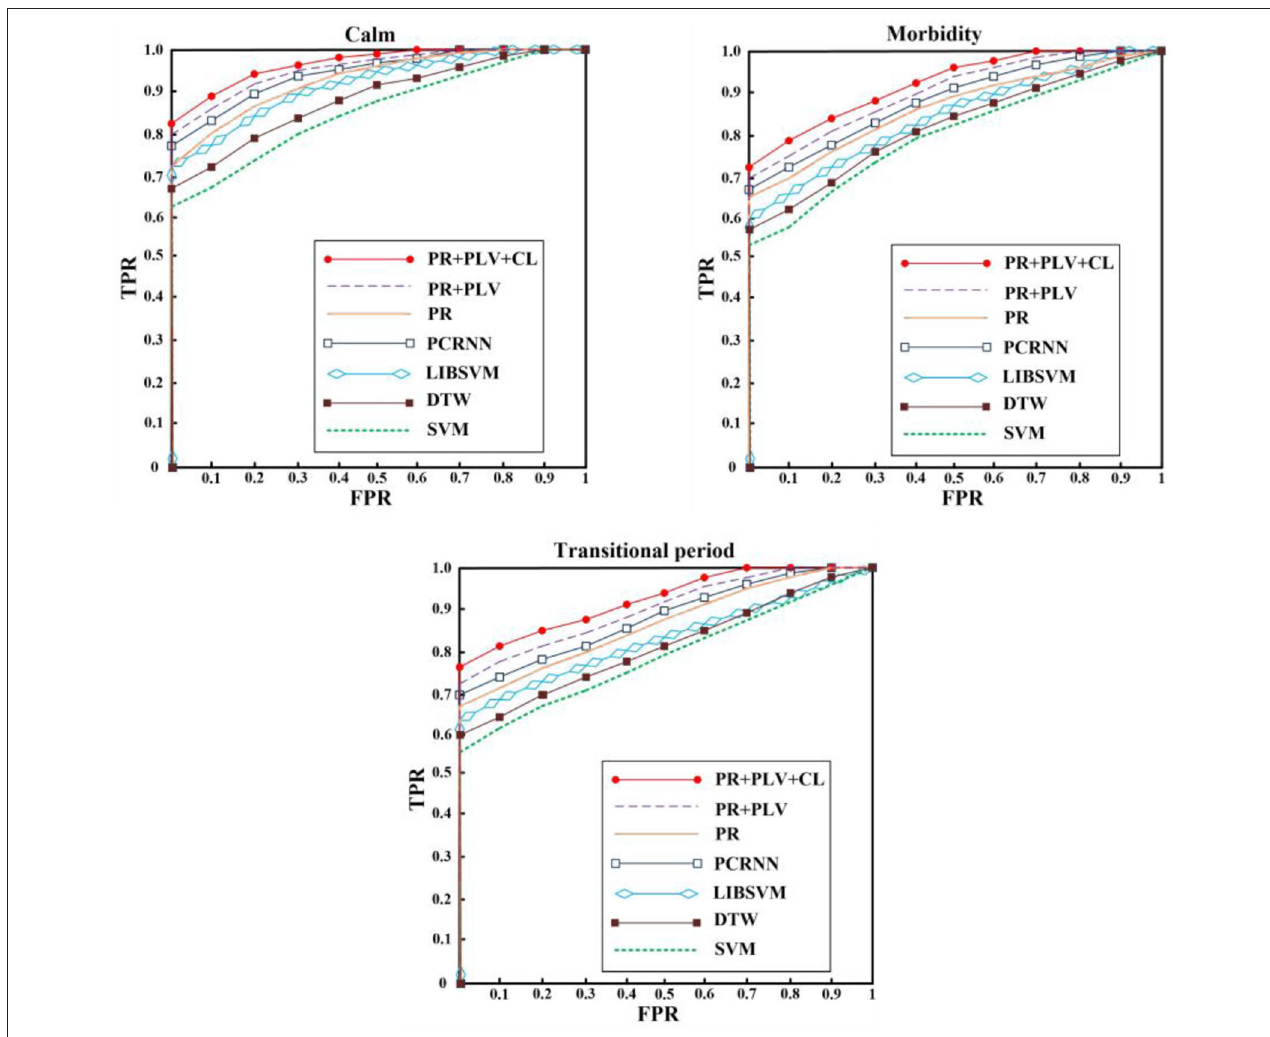
FIGURE 7 | Alzheimer’s disease ROC